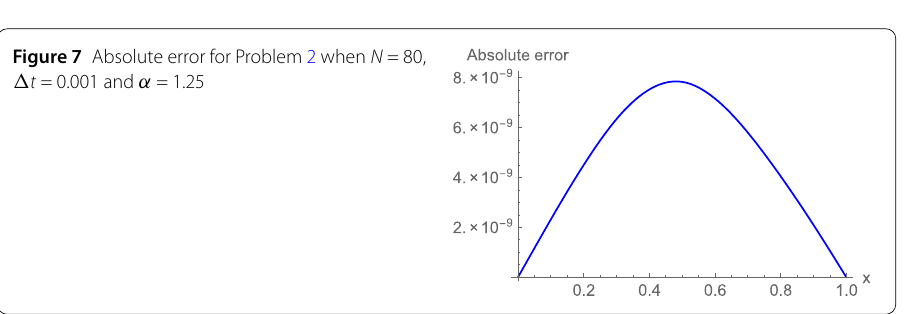
Figure 7 Absolute error for Problem 2 when N = 80, (cid:2) t = 0.001 and α =